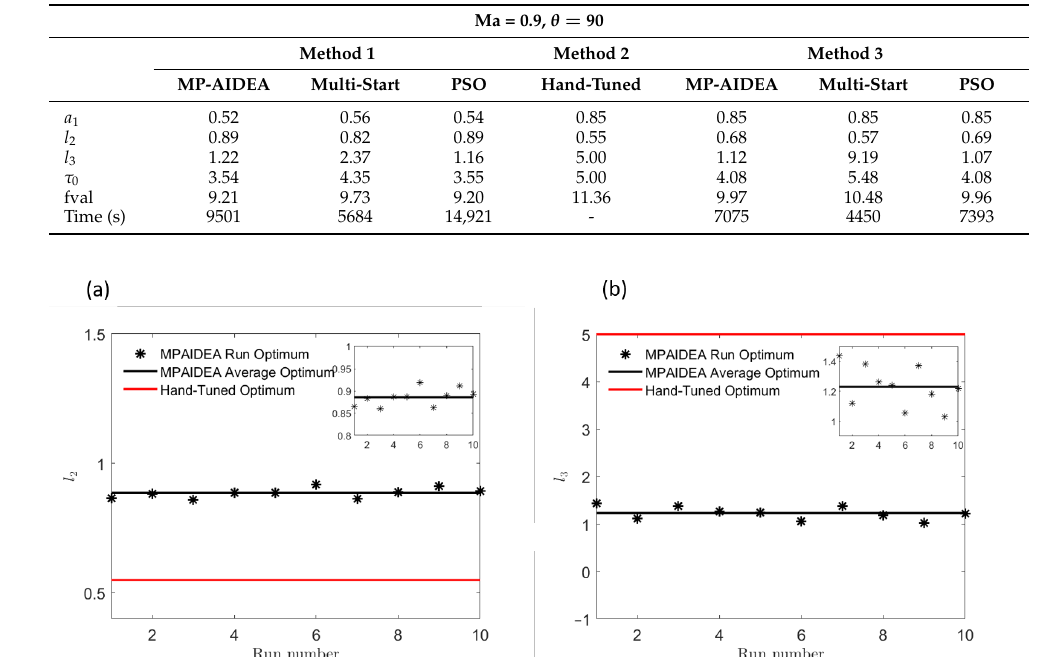
Table 4. Ma = 0.9, θ = 90: Comparison of parameters found from the optimization methods.